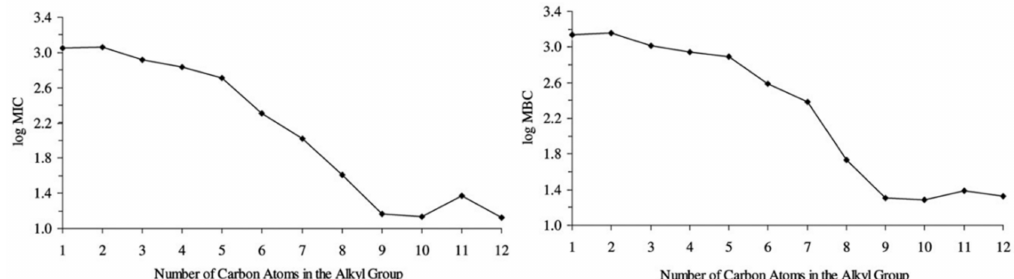
Figure 2. Mean Minimum Inhibitory Concentrations (MIC) and Minimum Biocidal Concentrations (MBC) for menthoxymethyl]-3-alkylimidazolium ILs in relation to the number of carbon atoms in the alkyl chain. Adapted from [19].